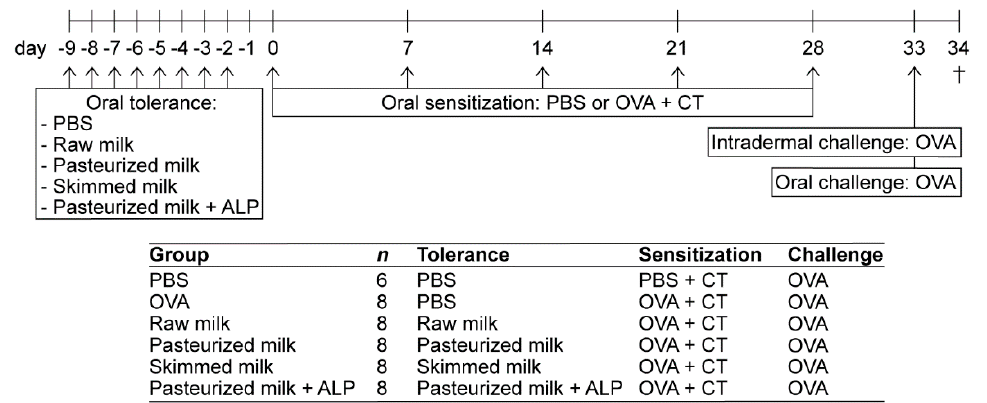
Figure 1. Schematic overview of the experimental setup. Female C3H/HeOuJ mice were randomly allocated to the control and experimental groups: PBS group (PBS-sensitized control mice; n = 6), OVA group (OVA-sensitized allergic mice; n = 8), raw milk group (raw milk-treated mice; n = 8), pasteurized milk group (pasteurized milk-treated mice; n = 8), skimmed milk group (skimmed milk-treated mice; n = 8) and pasteurized milk + ALP group (pasteurized milk + ALP-treated mice; n = 8). Mice were orally treated with 0.5 mL raw milk, pasteurized milk, skimmed milk, pasteurized milk spiked with ALP, or PBS (as a control). Following this oral tolerance induction period, mice were orally sensitized to OVA (20 mg / 0.5 mL PBS) with CT as an adjuvant (10 µ g / 0.5 mL PBS). PBS-sensitized control mice (PBS group) received CT alone. Subsequently, all mice were intradermally and orally challenged with OVA. Mice were killed on day 34 (as indicated by †). PBS, phosphate-buffered saline; ALP, alkaline phosphatase; OVA, ovalbumin; CT, cholera toxin.